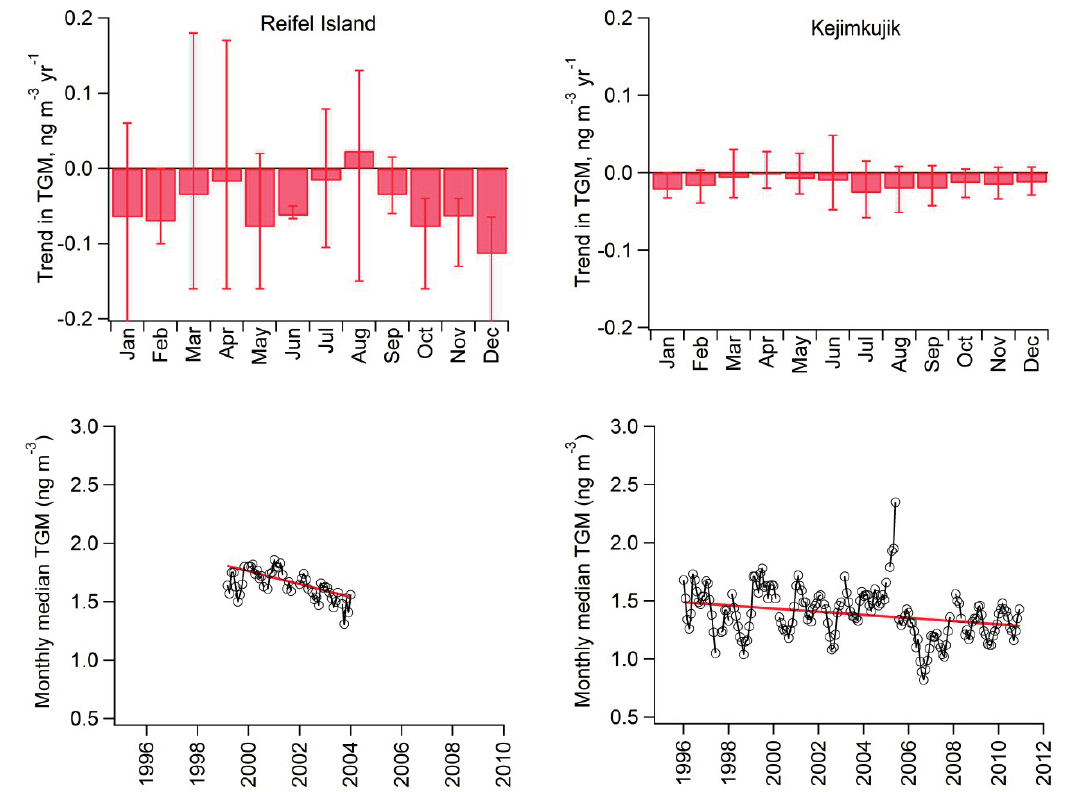
Figure 10. Long-term trends in TGM by season ( top ) and monthly median TGM with overall annual trend ( bottom ), at Reifel Island and